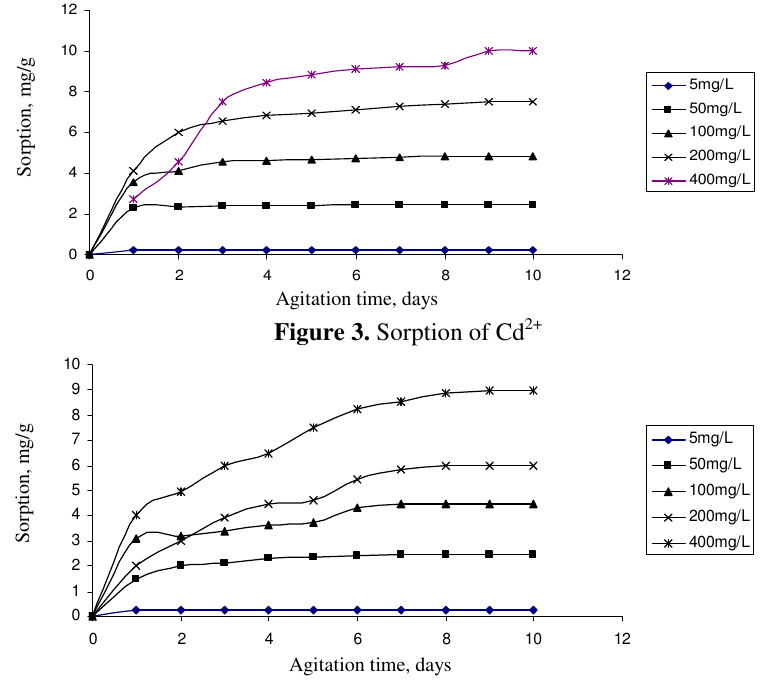
Figure 4. Sorption of Cd 2+ in presence of Cu